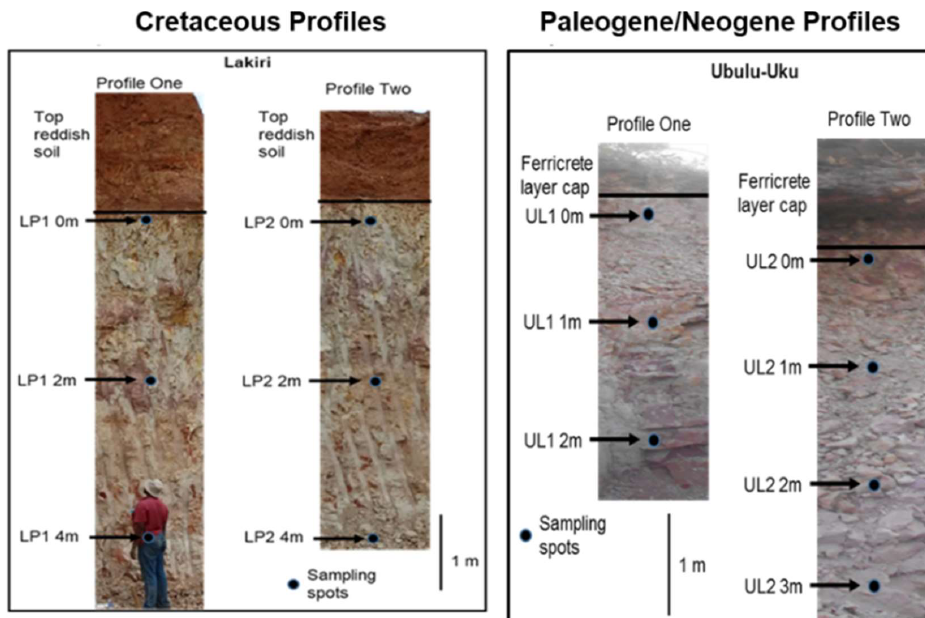
Figure 1. Vertical profiles showing sampling spots and lithologic units of the studied geophagic kaolinitic clay deposits (Modified from [30]).